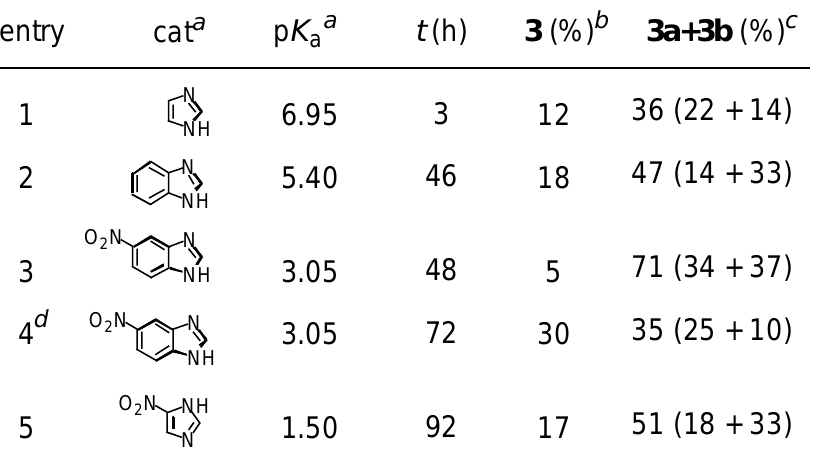
and the indicated 2